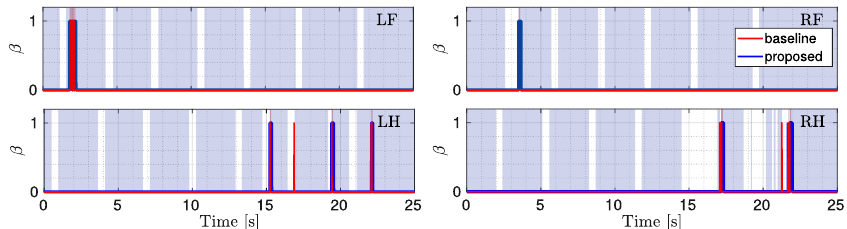
Figure 7. Comparison between the flags. The red one is obtained with the baseline approach, the blue one with the proposed approach. The gray shaded area shows stance phases and the red shaded area indicates the ground